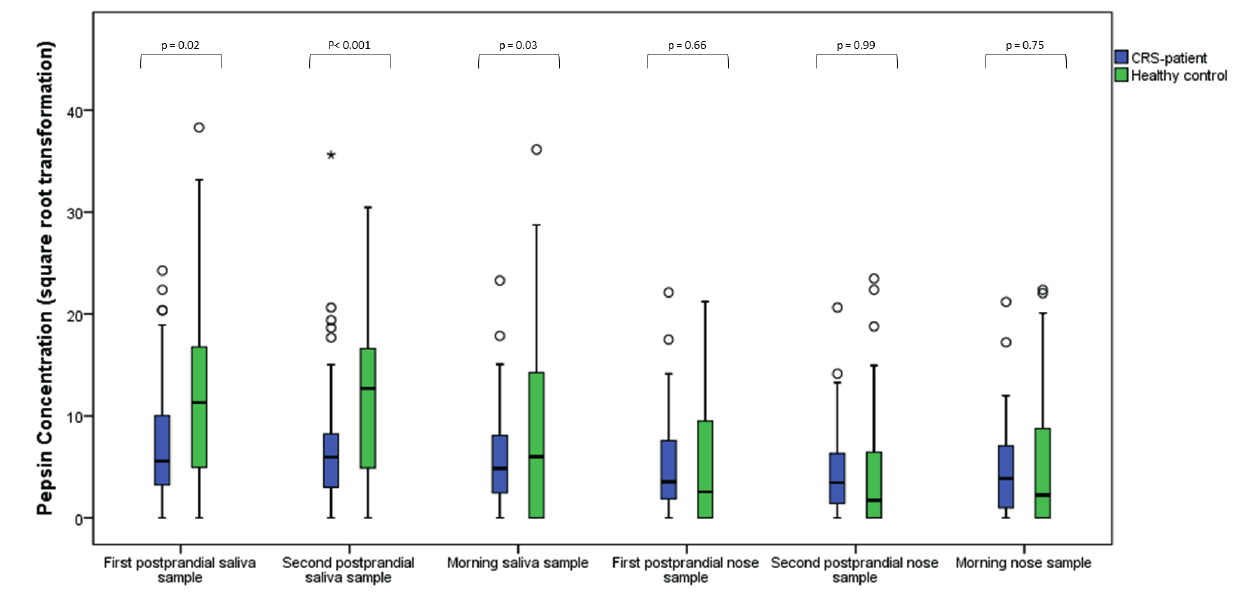
Figure 2. Pepsin concentration in nasal secretion and saliva in healthy controls and CRS-patients. Pepsin level in nasal secretion and saliva measured one hour after two different meals and within fifteen minutes after waking up in the morning. There were no significant differences in pepsin concen- tration in nasal samples between CRS-patients and healthy controls, but significantly higher pepsin concentration in saliva in healthy control subjects compared to CRS-patients, paired sample Wilcoxon test. The concentrations are square root transformed for improved